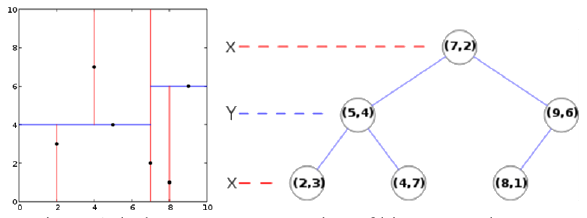
Figure 1. k-d trees are an extension of binary search trees Whereas quad- and octrees are limited in adapting to inhomogeneous data distributions, R-trees group nearby objects using minimum bounding rectangles or boxes in the next higher level of the tree. The key difficulty of R-trees is to build balanced trees and to minimize, both, coverage and overlap of node bounding hyperboxes (Beckmann et al., 1990).